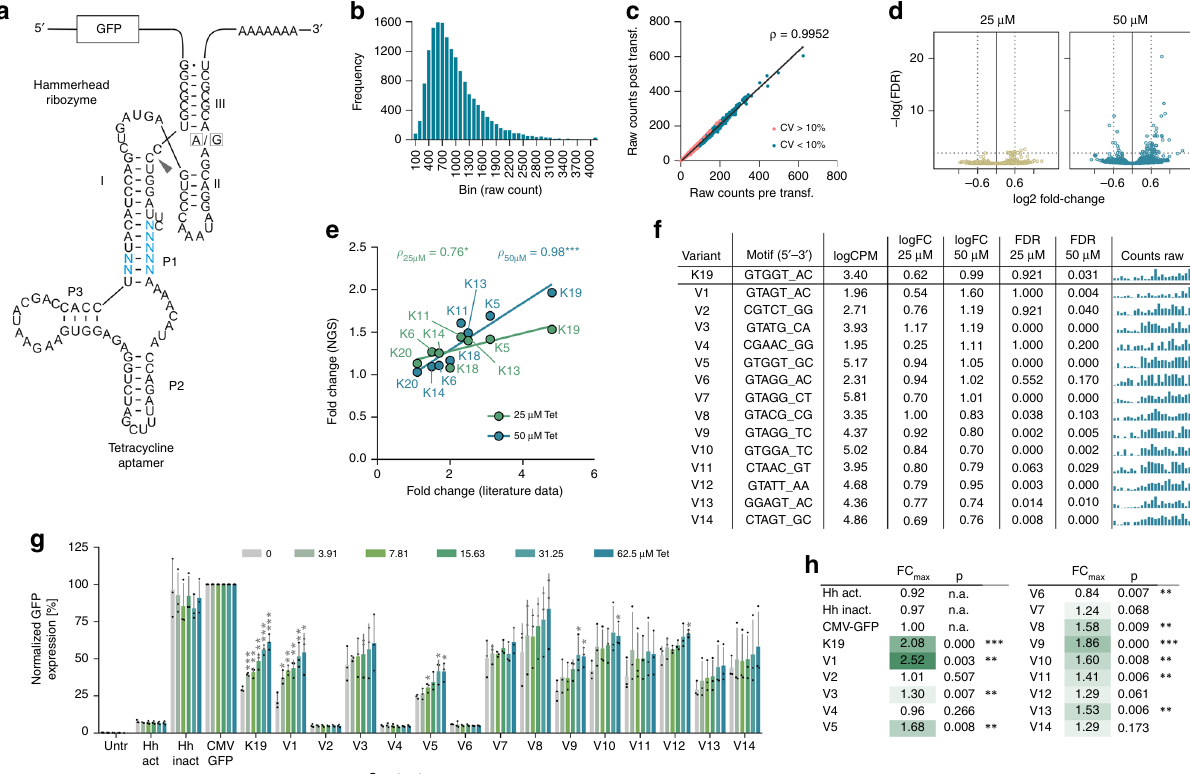
Fig. 2 Identi fi cation of Tet-responsive hammerhead ribozymes by amplicon-seq. a Secondary structure of the Tet-hammerhead ribozyme library design. Blue nucleotides indicate the randomized motif. The arrowhead indicates the cleavage site. A/G mutation at the indicated position renders the ribozyme inactive. b Tet riboswitch construct frequency analysis of the original library and c conservation of complexity following transfection in HEK-293 cells. CV, coef fi cient of variation. d Volcano plots displaying the signi fi cance (FDR) of changes in riboswitch abundance as a function of the change in expression (log 2 fold change). e Correlation of expression induction upon Tet for constructs and associated fold changes reported by Beilstein et al. 4 ( X -axis) with fold changes measured in our screen ( Y -axis). f Selected hits from the Tet riboswitch library screen, randomized sequence, mean counts per million (CPM), fold change (FC) and false-discovery rate (FDR) at 25 and 50 µ M Tet, respectively. The bar plots show the raw counts under untreated, 25 µ M and 50 µ M Tet- stimulated conditions (three groups from left to right, n = 8 replicates each). g Functional hit validation in HEK-293 cells ( n = 3 experiments, mean ± s.d.); Hh-act/inact: constitutively active/inactive ribozyme control. h Maximal fold changes and p-values measured upon stimulation vs. 0 µ M Tet for all tested constructs. * p < 0.05, ** p < 0.01, *** p < 0.001 (unpaired T -Test, two-tailed). Source data are provided as a Source Data fi